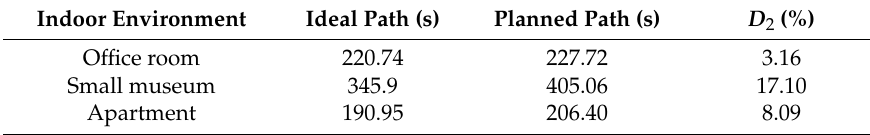
Table 3. Comparison between total time consumption of planned path and ideal